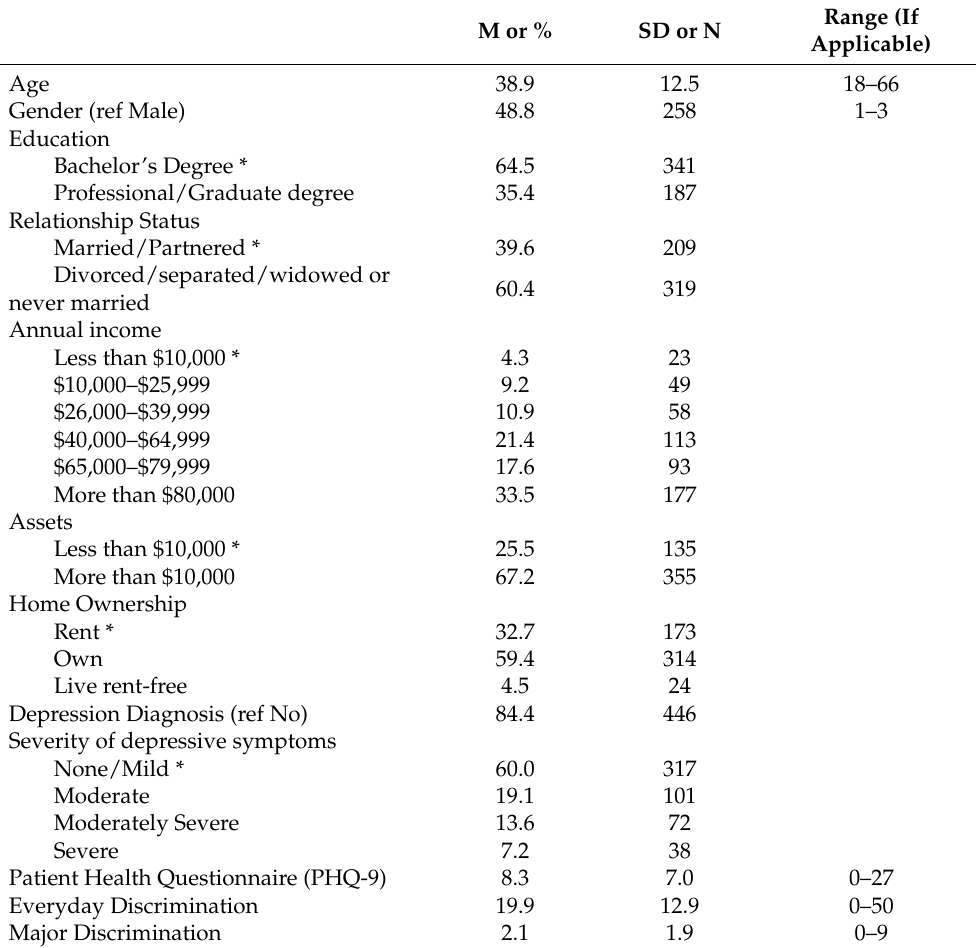
Table 1. Descriptive and Sample Characteristics Statistics (N =